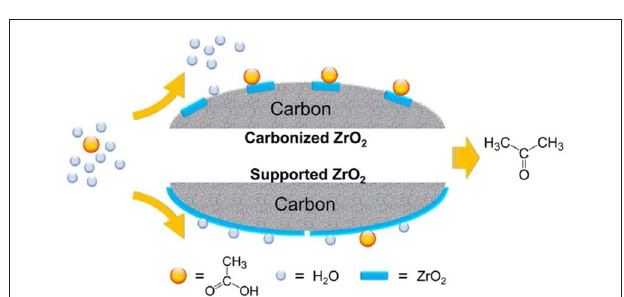
FIGURE 12 | Comparison between the surface of high carbonized ZrO 2 catalysts and conventional catalysts. Reprinted with permission from Wu et al. (2017b) ; American Chemical